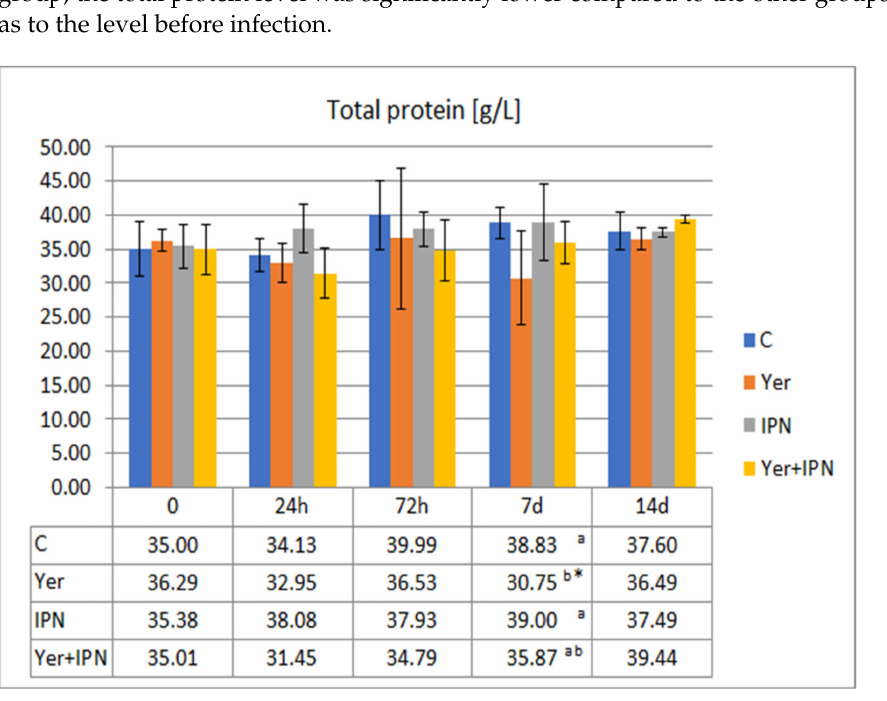
Figure 11. Mean values and standard deviation of total protein levels over the course of the second experimental infection. *—statistically significant differences compared to the day 0 values within a given group ( p ≤ 0.05); a, b —statistically significant differences between the groups on a given sampling day ( p ≤